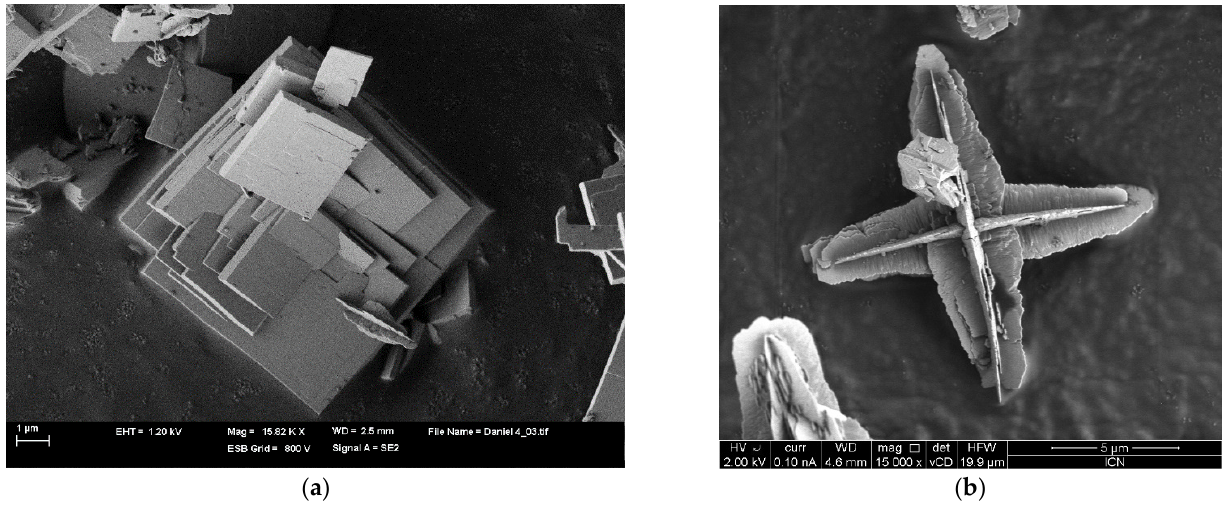
Figure 6. SEM Micrographs of: ( a ) (NH 4 ) 2 V 7 O 16 microsquares, and ( b ) Isolated VO 2 cross.